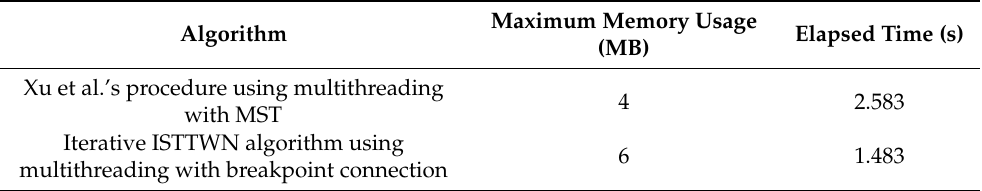
Table 5. Comparison between the existing algorithm and the proposed algorithm under multithreading.